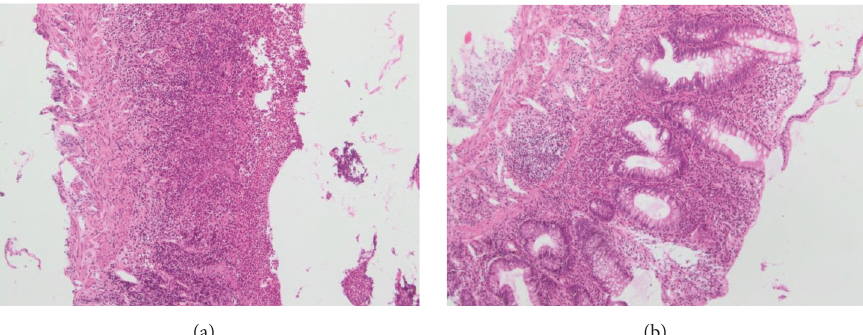
Figure 4: Desquamation and damage to the surface epithelium. Architecturaldistortion: duplication of crypts and irregular glands of varying sizes. Inflammatory infiltrate formed by neutrophils and plasmocytes in the lamina